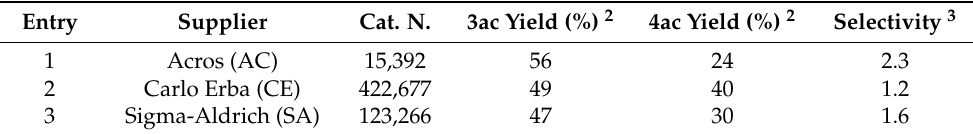
Table 2. Direct arylation of 1-methylimidazole 1a with 1-bromo-4-nitrobenzene ( 2c ) in anisole from different suppliers 1